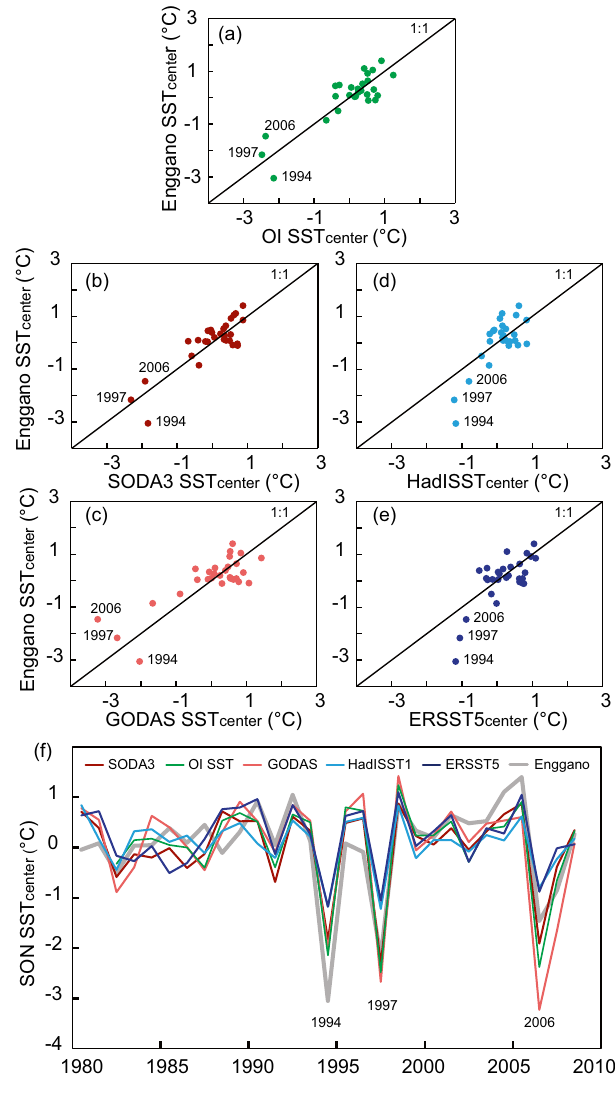
Figure 4. Scatter plots ( a – e ) and time series ( f ) of September–November SSTs from various SST products compared with Enggano coral SSTs for the time period of 1982–2008. ( a ) OISST vs. Enggano SST (green), ( b ) SODA3 vs. Enggano SST (dark red), ( c ) GODAS vs. Enggano SST (light red), ( d ) ERSST5 vs. Enggano SST (dark blue), ( e ) HadISST1 vs. Enggano SST (light blue). Note the cool anomalies during the extreme pIOD events in 2006, 1997 and 1994, which are underrepresented in HadISST1 and ERSST5. All time series have been centred to their